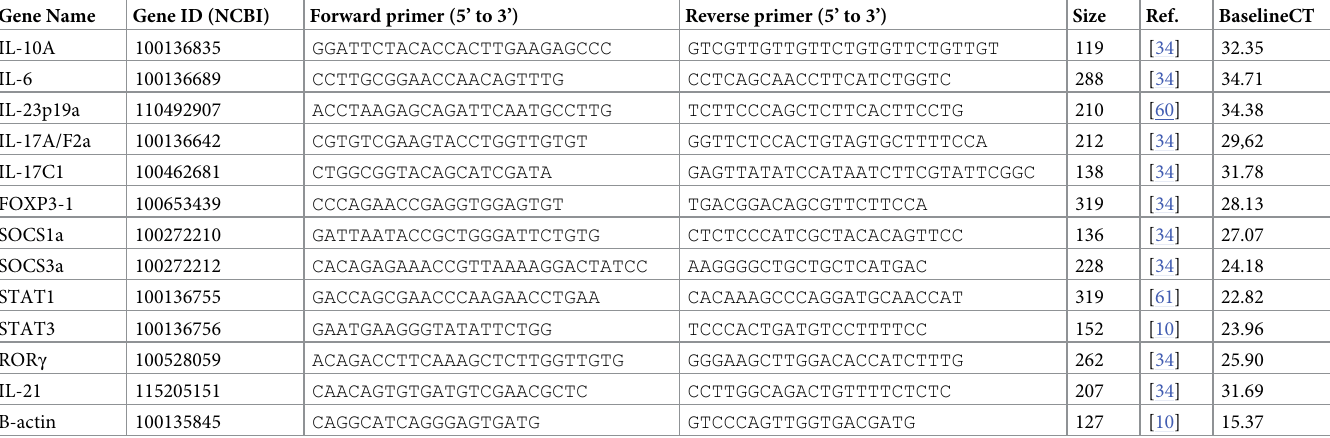
Table 1. Rainbow trout oligonucleotides used in this